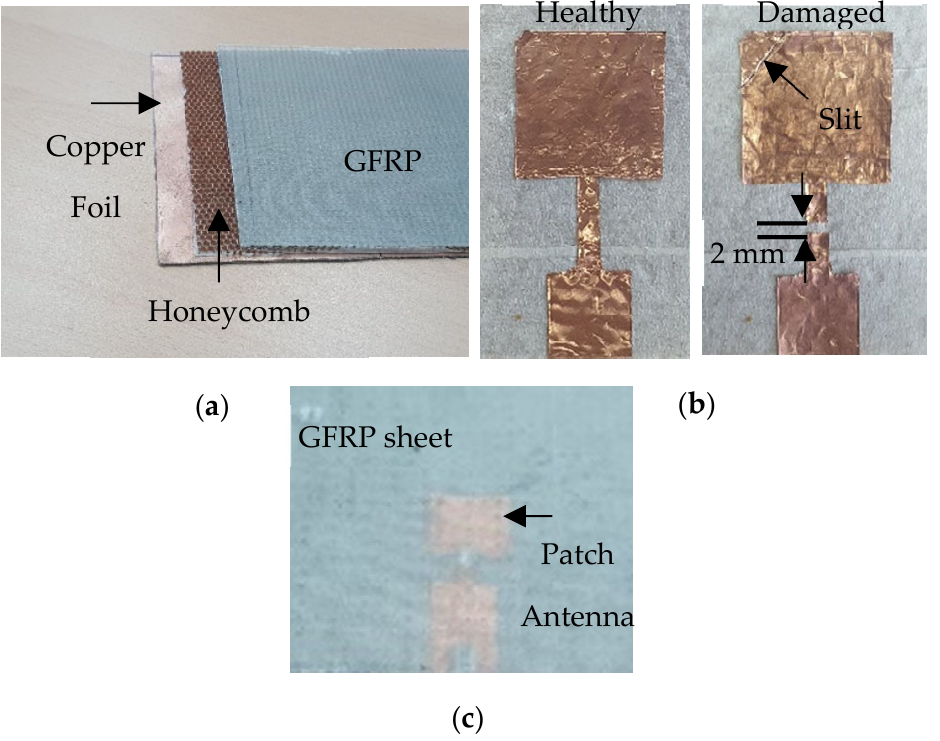
Figure 6. ( a ) Picture of the individual layers of the composite structure, ( b ) the C-band patch antenna fabricated on a honeycomb substrate and ( c ) the embedded antenna covered with a GFRP sheet. The patch antenna dimensions measured 27 mm by 25.88 mm, with a quarter-wavelength transformer width of 4 mm and length of 15 mm, in line with the simulations. The 50-ohm feed of the antenna is also 15 mm long with a width of 14.75 mm to ensure 50-ohm matching.